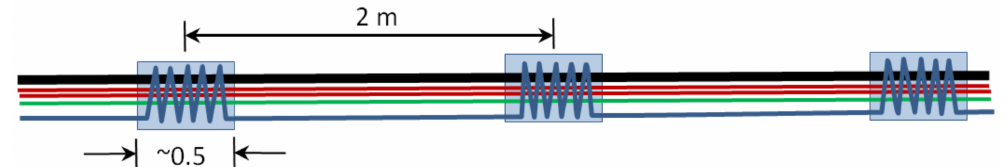
Figure 2. Diagram of typical section of cable. Represented are the main 13.3 mm 2 copper energy feed cable (black), the 2.08 mm 2 copper linear heating cable (green, not used), the intermittent, or “dotted line” segmented 5.26 mm 2 heating cable (blue), and the loop of fiber optic cable (red). The light blue boxes over the wrapped sections represent the HDPE protection sleeves placed over the heating “dots” in the lower 264 m of the installation to prevent abrasion damage during installation.